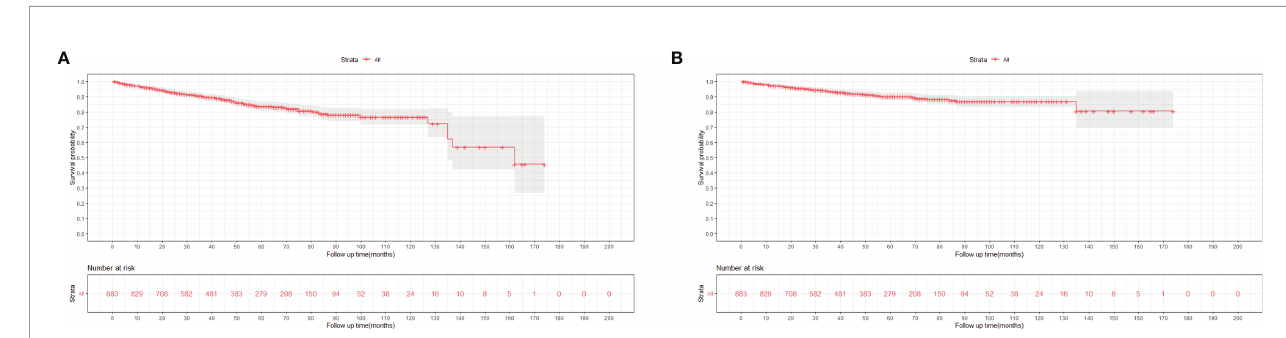
FIGURE 5 | Kaplan-Meier survival analysis of all patients with HIV-associated CTCL: (A) OS; (B). DSS. HIV-associated CTCL, human immunode fi ciency virus associated cutaneous T-Cell. lymphoma; OS, overall survival; DSS, disease-speci fi c survival.